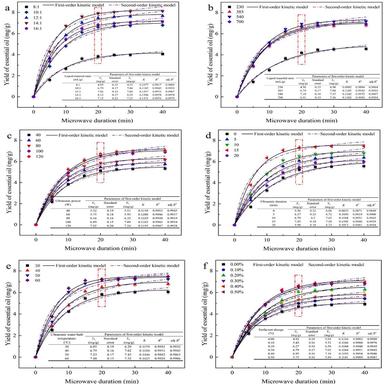
Effecting factors on the yield of PKSSEO. Liquid material ratio (a), microwave power (b), ultrasonic power (c), ultrasonic duration (d), ultrasonic water bath temperature (e), and surfactant dose (f); Ya and Ye are the actual response values and expected response values, respectively.